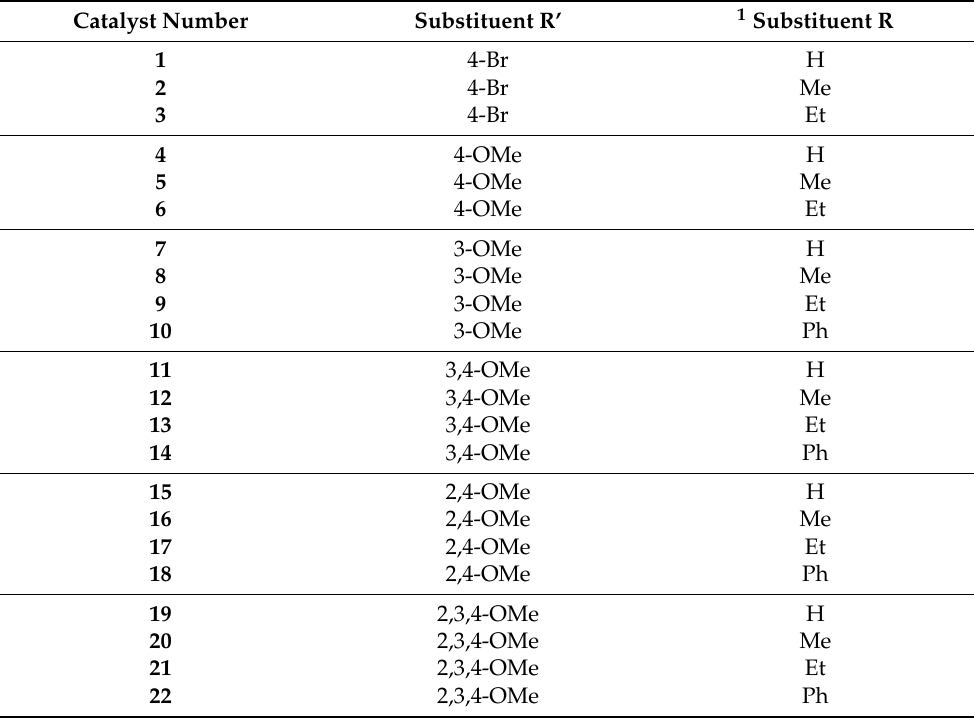
Table 1. Summary of the substituents of the catalysts. Catalyst